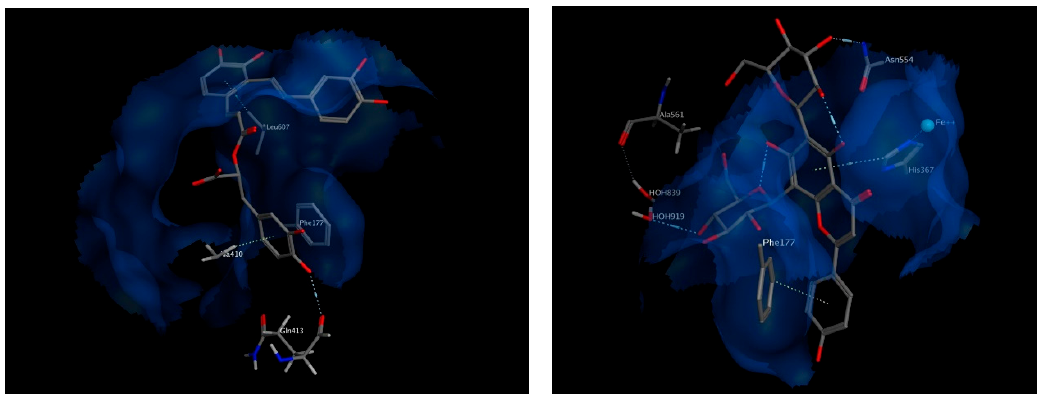
Figure 8. 3D view of interactions of Salvianolic acid A as well as Apigenin 6,8-di-C-hexosides with amino acid residues of 5-LOX. Side chains of amino acids were omitted for clarity, except for Gln413 and Ala561, whose backbones participate in hydrogen bonding with the docked